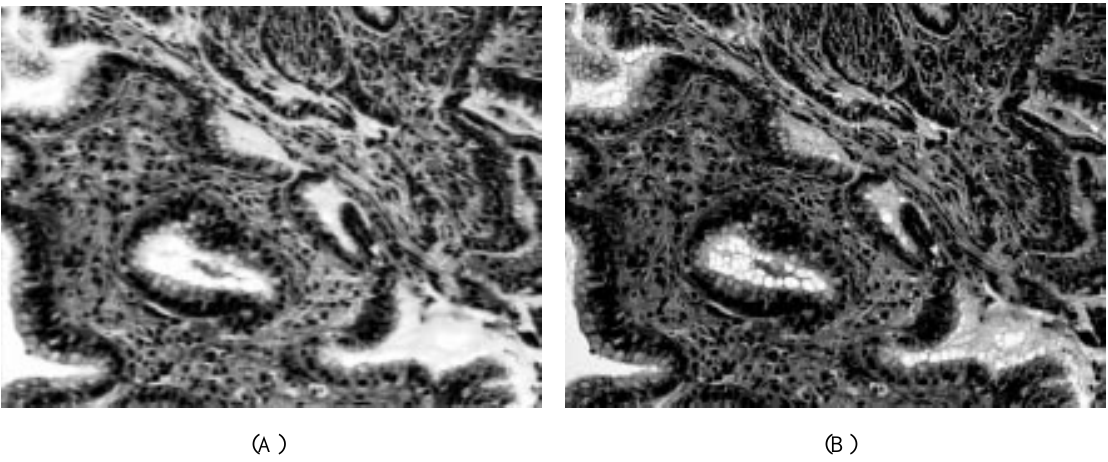
Fig. 2. The same field (gastrointestinal biopsy, HE, 20 (cid:2) ) acquired through the dynamic (A) and through the static (B)